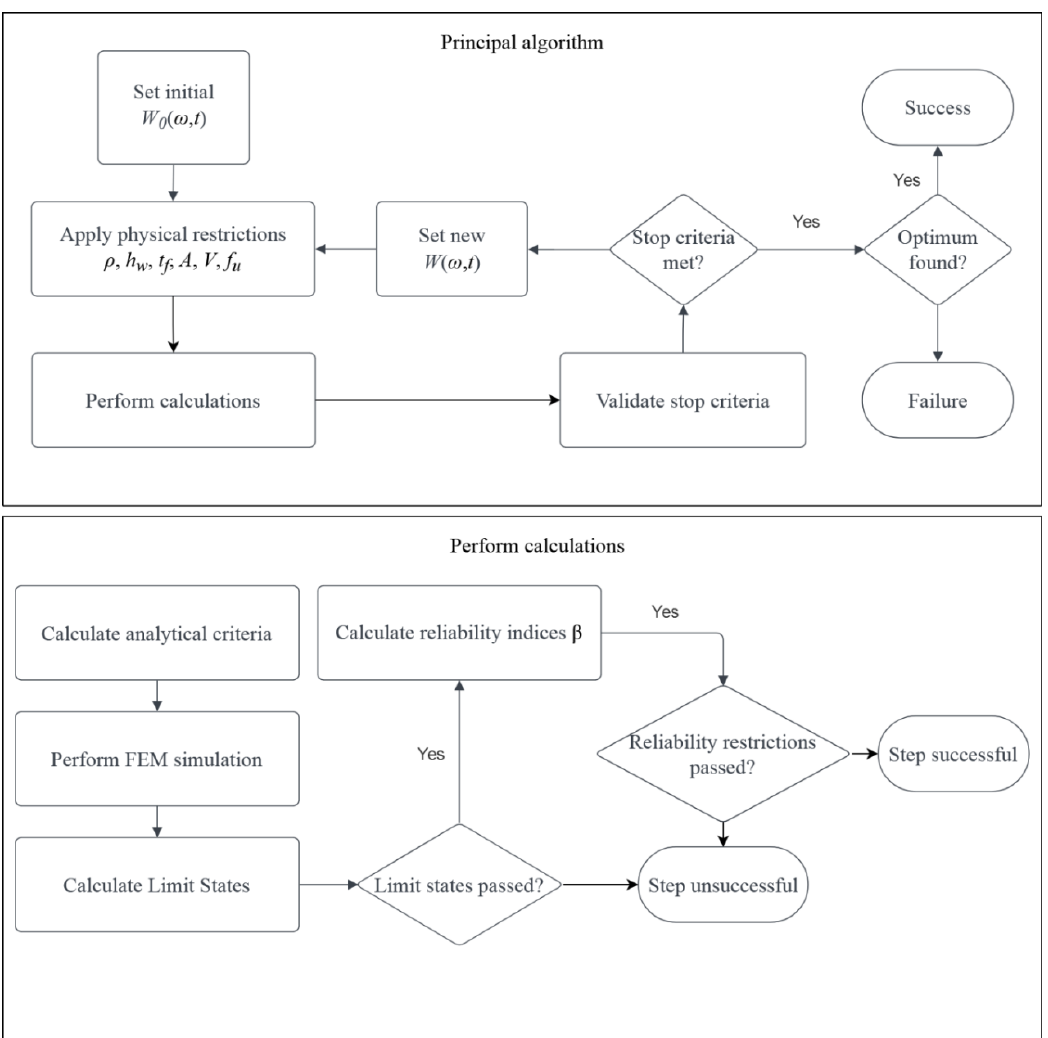
Figure 1. Principal algorithm of the method and calculation process.